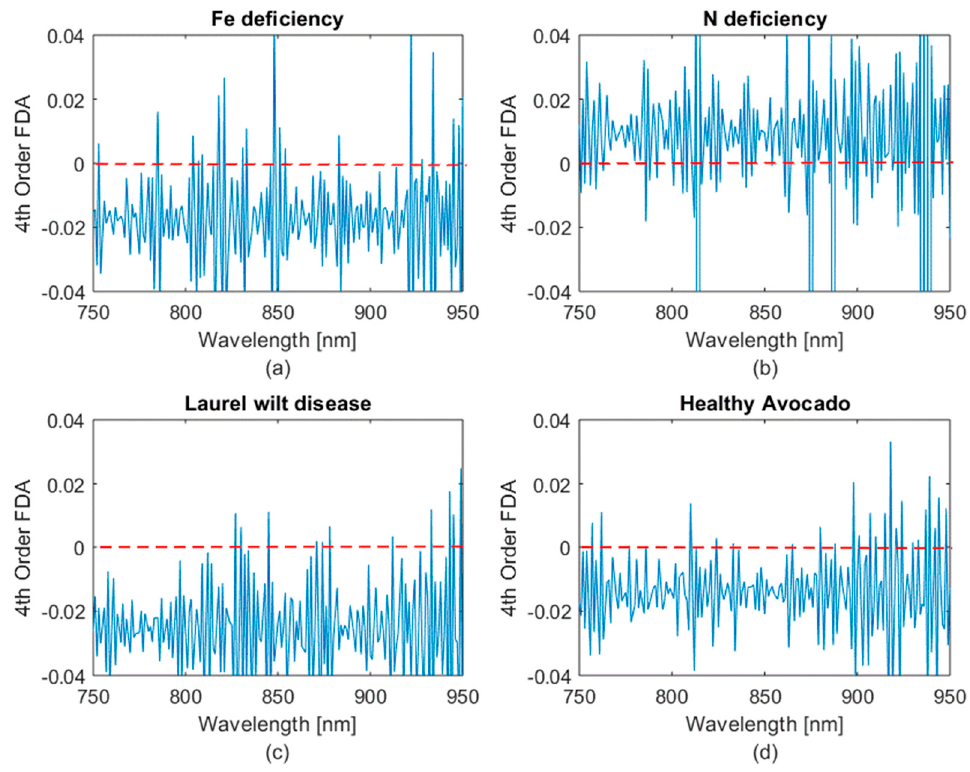
Figure 3. Fourth order finite difference approximations (FDAs) for each group of avocados in [750, 950] nm, normalized and transformed: ( a ) Fe-Deficient FDA; ( b ) N-deficient FDA; ( c ) Lw disease FDA; and ( d ) Healthy plants FDA; Note zero crossings’ variations between groups.